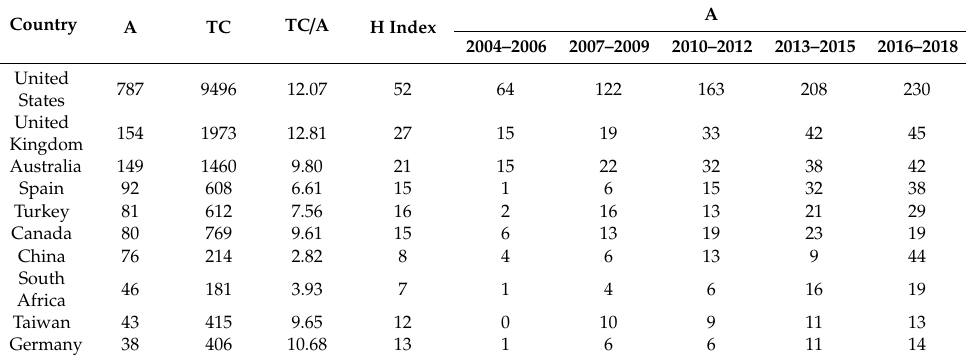
Table 7. Most productive countries in number of articles on the impact of the university classroom on managing the socio-educational well-being (2004–2018). Country A TC TC / A H Index A